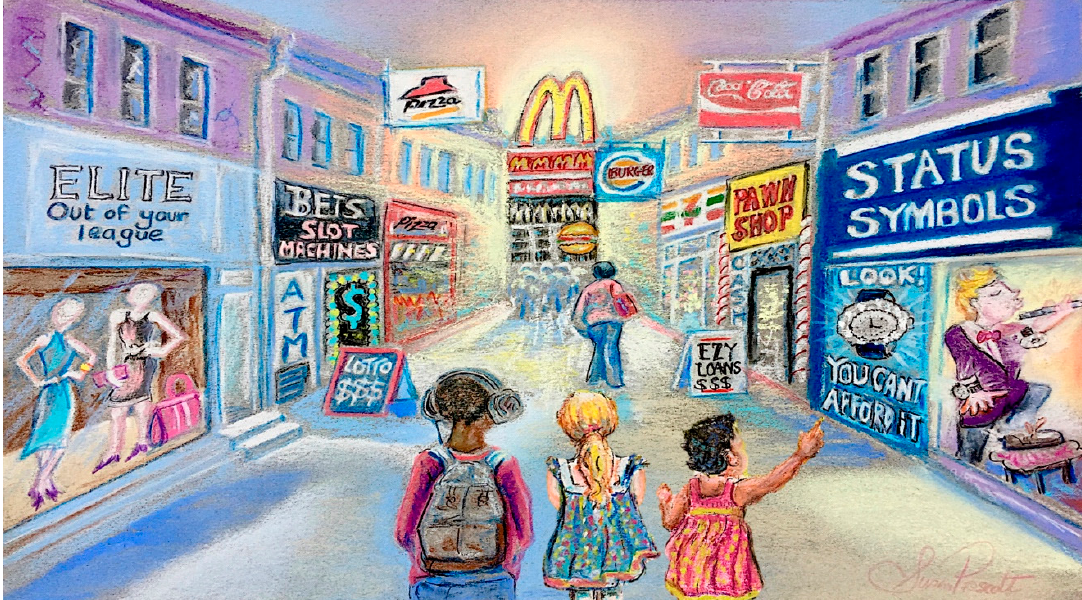
Figure 4. Environmental cues that promote ‘feelings’ of social inferiority and powerlessness increase preferences for fast-food and higher overall caloric intake